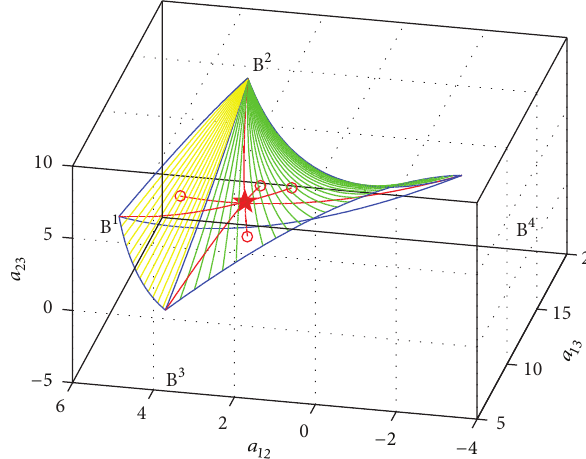
Figure 4: The Riemannian mean of three points.